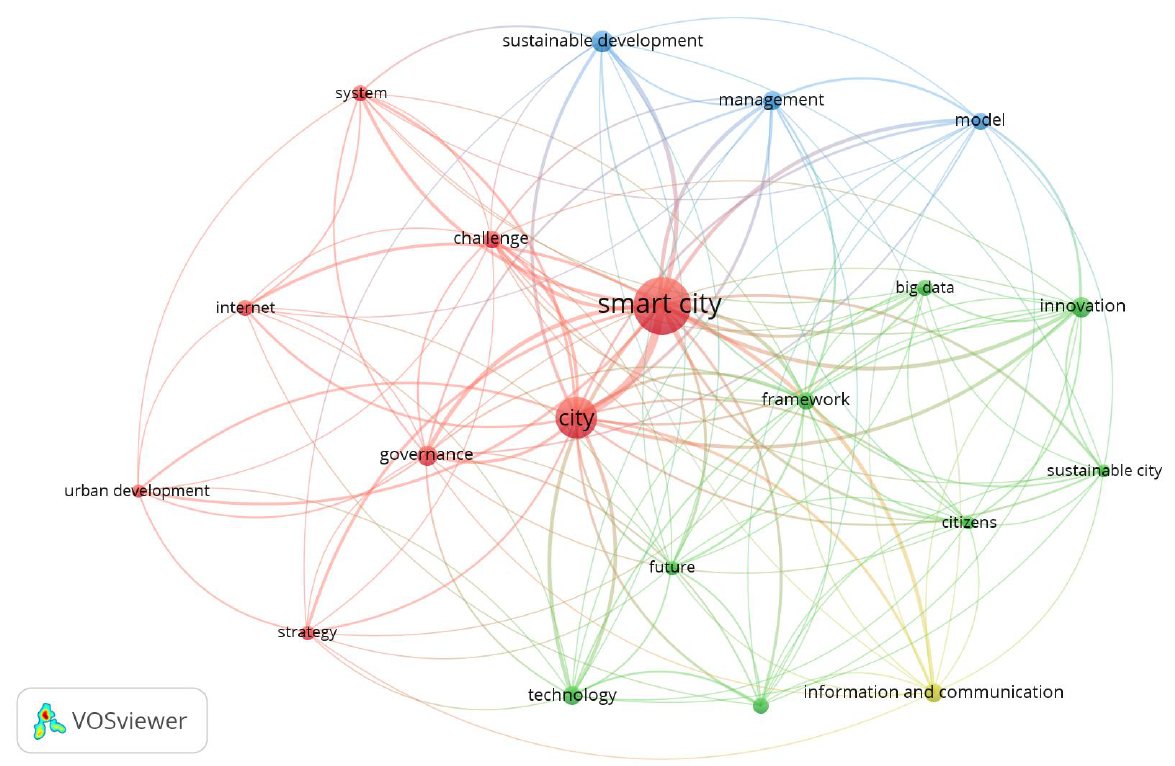
Figure 4. Network visualization Development Period.